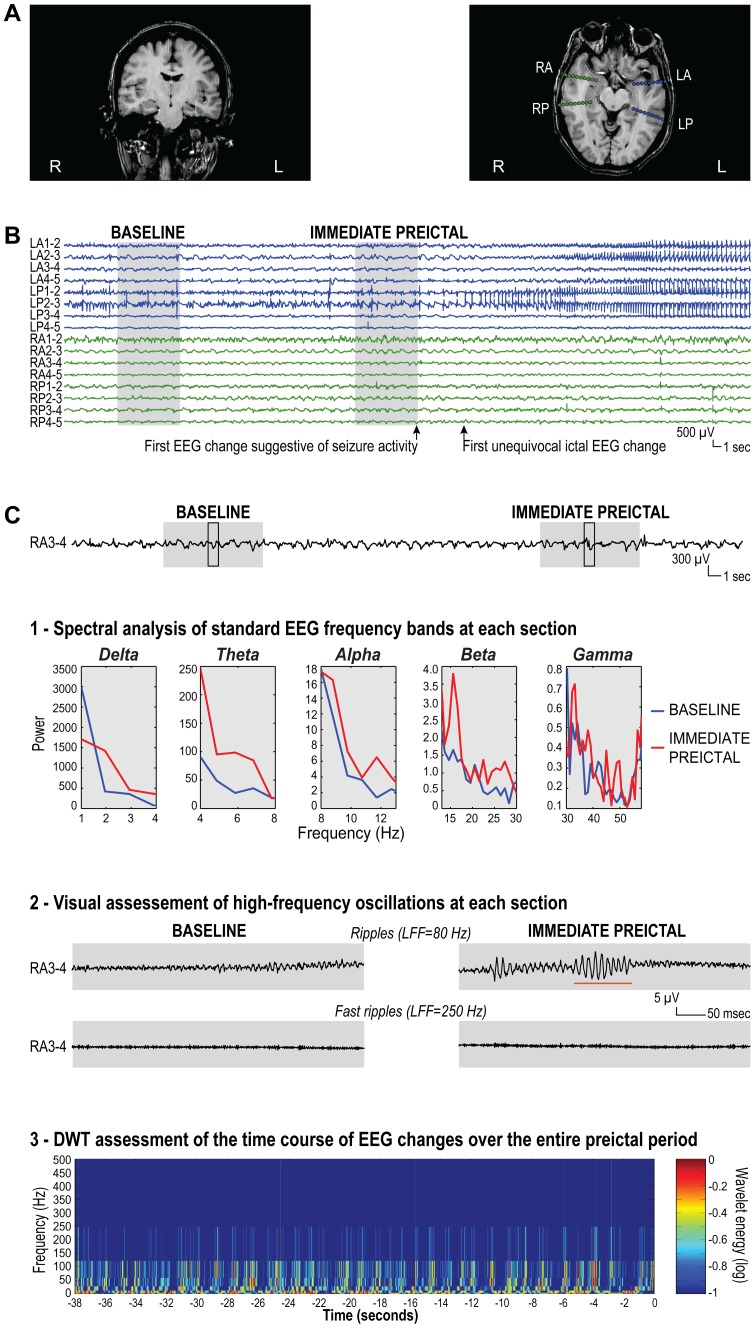
Assessment of preictal EEG changes in a patient with left mesial temporal atrophy.(A) MRI images showing marked volume loss in the left hippocampal formation (coronal T1-weighted image), and the depth electrode implantation sites (amygdala and hippocampus on each side) aimed at ruling out the possibility of bilateral independent temporal lobe seizure foci (axial T1-weighted image). (B) Seizure in which the first unequivocal ictal EEG change, a build-up of medium-to-high amplitude polypsikes at LP1-2, 2-3 (arrow), was preceded 6 seconds earlier by an insidious increase in spiking activity at the same contacts (first EEG change suggestive of seizure activity, arrow). (C) Assessment of different EEG frequency bands at contacts RA3-4, which were located in the hemisphere contralateral to the seizure-onset zone. This was performed at each section and over the entire period extending from one section to the other: 1) identification of standard EEG frequency bands (delta, theta, alpha, beta and gamma) at each section using spectral analysis. Note the increase in spectral power across all bands from the baseline (blue line) to the immediate preictal section (red line). These increases in power, which were small in magnitude, were virtually undetectable by visual inspection of the raw EEG signal; 2) visual analysis of high-frequency oscillations at each section, after extension of the time scale and high-pass filtering at 80 Hz (ripples) and 250 Hz (fast ripples). The EEGs shown here correspond to the segment of the original EEG signal included in the black-framed box within each section. Note that, while no ripple was found in the baseline, occasional ripples were observed in the immediate preictal section (as indicated by the orange underscore). No fast ripple was found in either section; 3) assessment of the time course of EEG changes over the entire period extending from the beginning of the baseline to the end of the immediate preictal section using discrete wavelet transform. Preictal changes were not clearly visible on the time-frequency map. R = right; L = left; RA = right amygdala; RP = right posterior hippocampus; LA = left amygdala; LP = left posterior hippocampus; LFF = low-frequency filter; DWT = discrete wavelet transform.